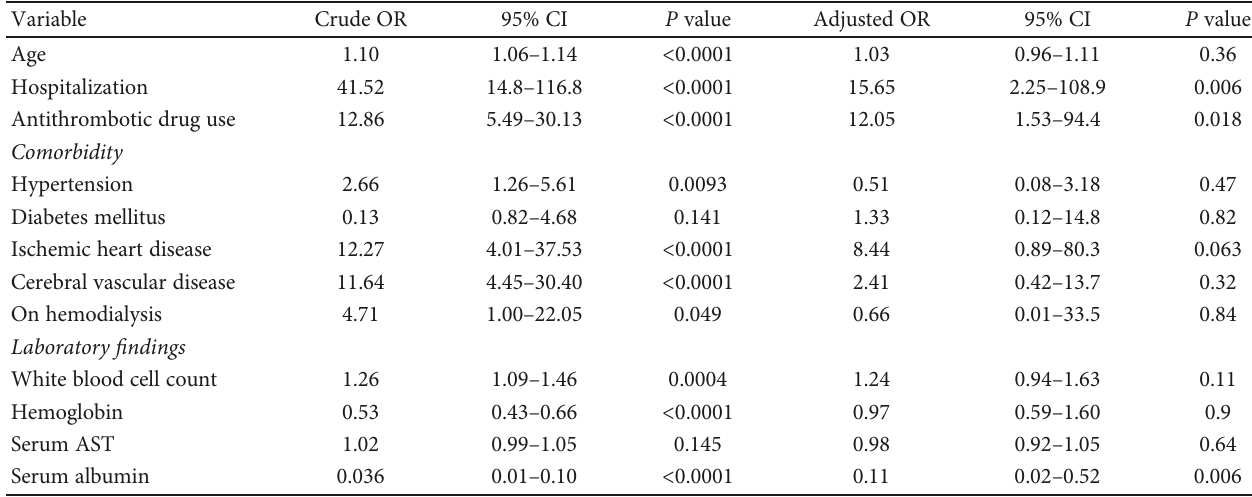
Table 2: Bivariate and multivariate logistic regression analyses.